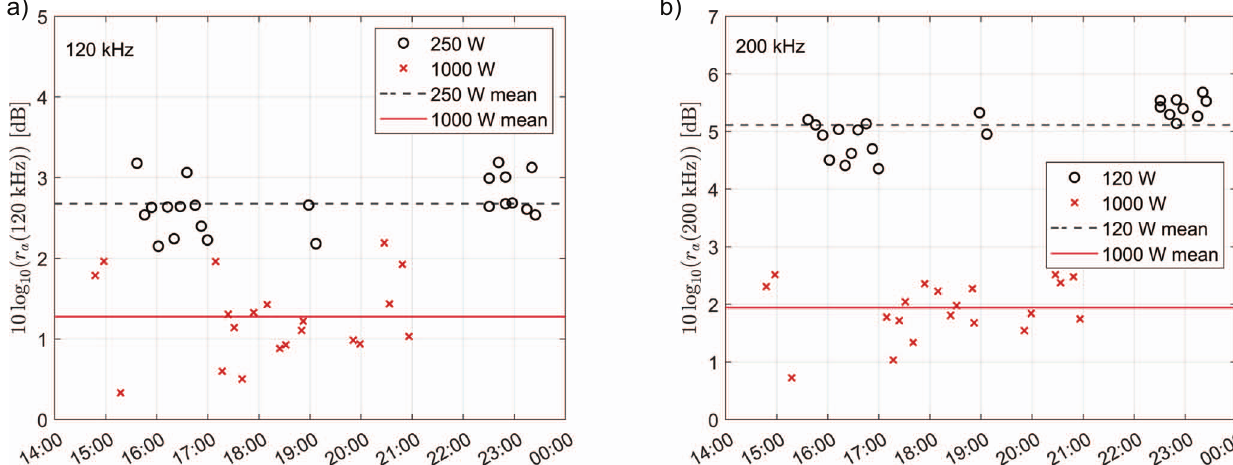
Figure 2. Measured relative frequency response, r a ( f ), obtained from oceanic in-situ acoustical survey measurements of s v on Atlantic mackerel schools. Data from within an observation depth interval of 30 m to 110 m are included. Each point (x or o) is based on measurements from a whole school. (a) 120 kHz measurement frequency, using 250 W and 1000 W electrical power settings in survey operation (alternating), and 250 W during calibration. (b) 200 kHz measurement frequency, using 120 W and 1000 W electrical power settings in survey operation (alternating), and 120 W during calibration.